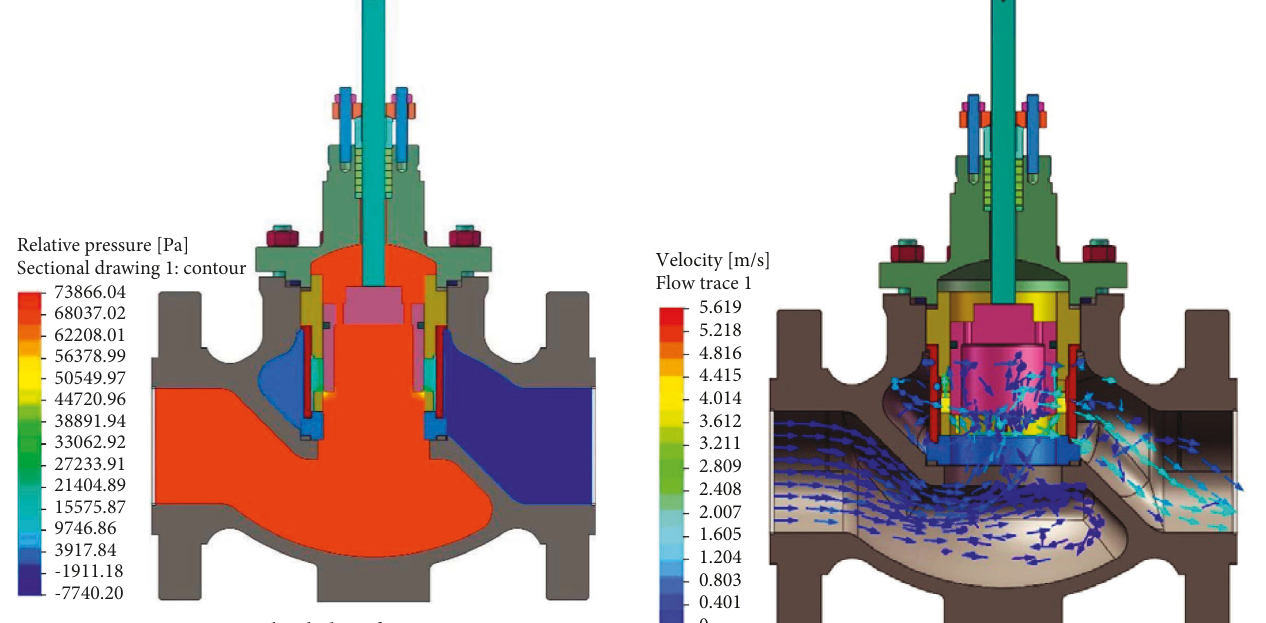
Figure 9: Pressure cloud chart for 20% opening.